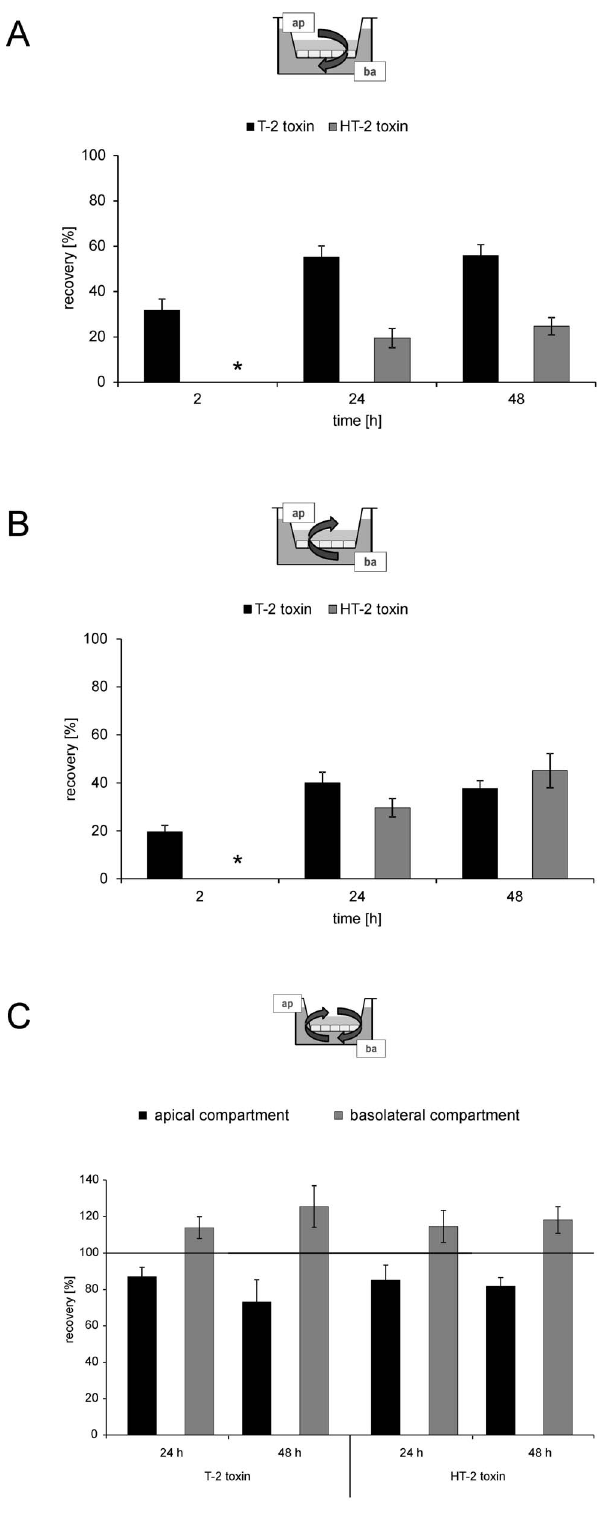
Figure 6. Permeation of T-2 and HT-2 toxin across PBCEC monolayers after various time points. A: Recovery of T-2 and HT-2 toxin (% of initially applied toxin) in the basolateral compartment after application of toxin (T-2 toxin: 25 nM; HT-2 toxin: 50 nM) to the apical compartment for 2 h, 24 h and 48 h. B: Recovery of T-2 and HT-2 toxin (% of initially applied toxin) in the apical compartment after application of toxin (T-2 toxin: 10 nM; HT-2 toxin: 50 nM) to the